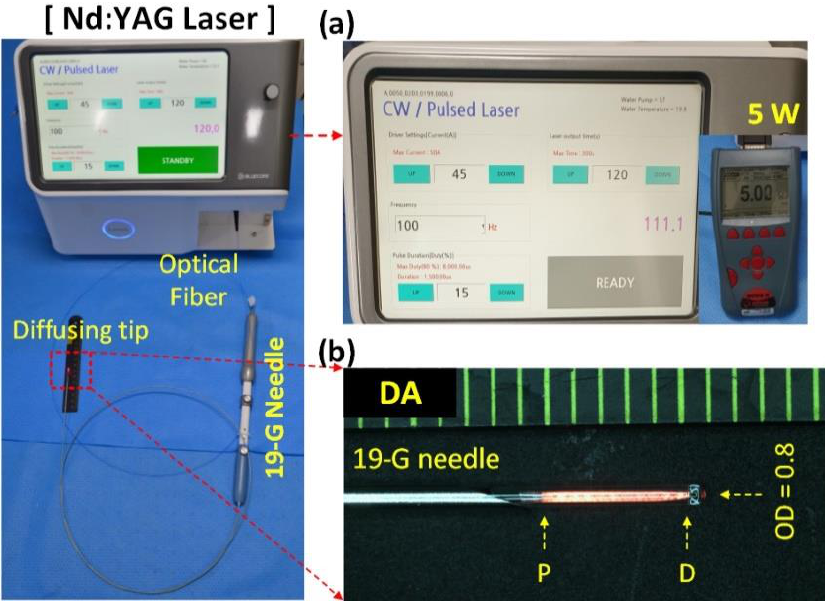
Figure 1. Endoscopic ultrasound (EUS)-guided laser ablation (LA) on pancreatic tissue in vivo in porcine models with diffusing applicator (DA) through 19 G biopsy needle: ( a ) schematic of cus- tomized Nd:YAG laser system and ( b ) uniform HeNe light distribution along the DA (P = proximal and D = distal ends; OD = outer diameter of DA).